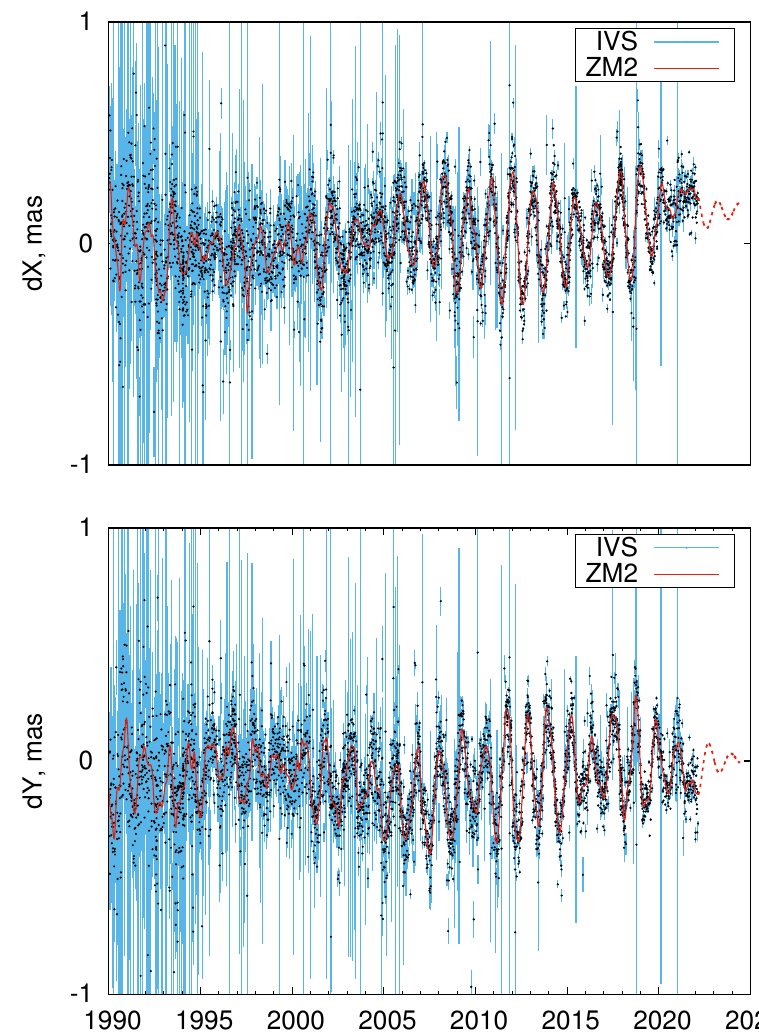
Figure 1. ZM2 (red line) and IVS (black points with blue error bars) CPO series. Dashed red line shows ZM2